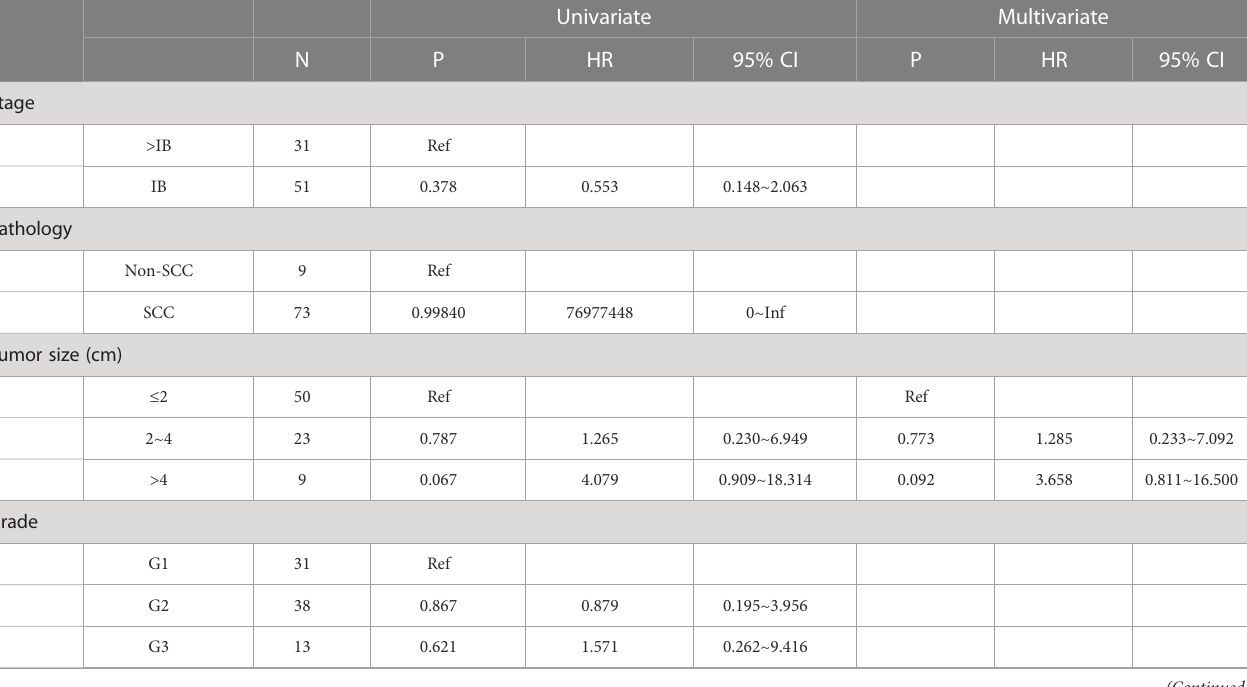
TABLE 2 Univariate and multivariate analyses of OS in the post-PSM cohort (N = 82).